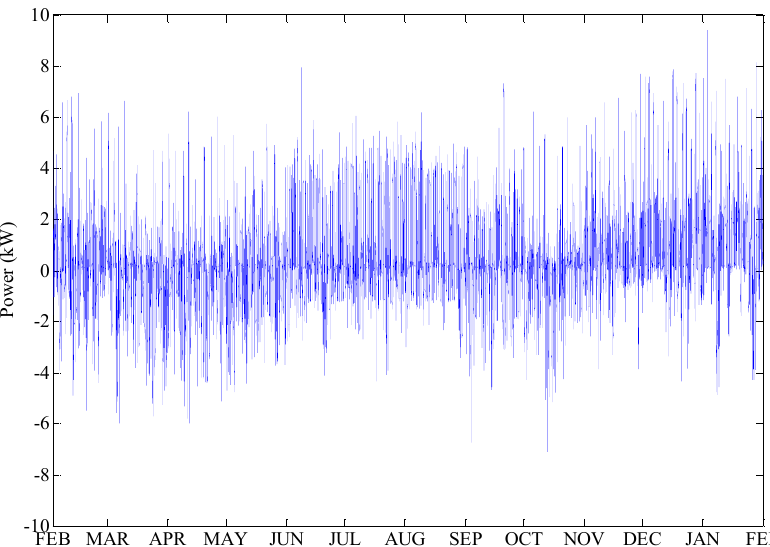
Figure 2. Net power profile within the microgrid during a year.